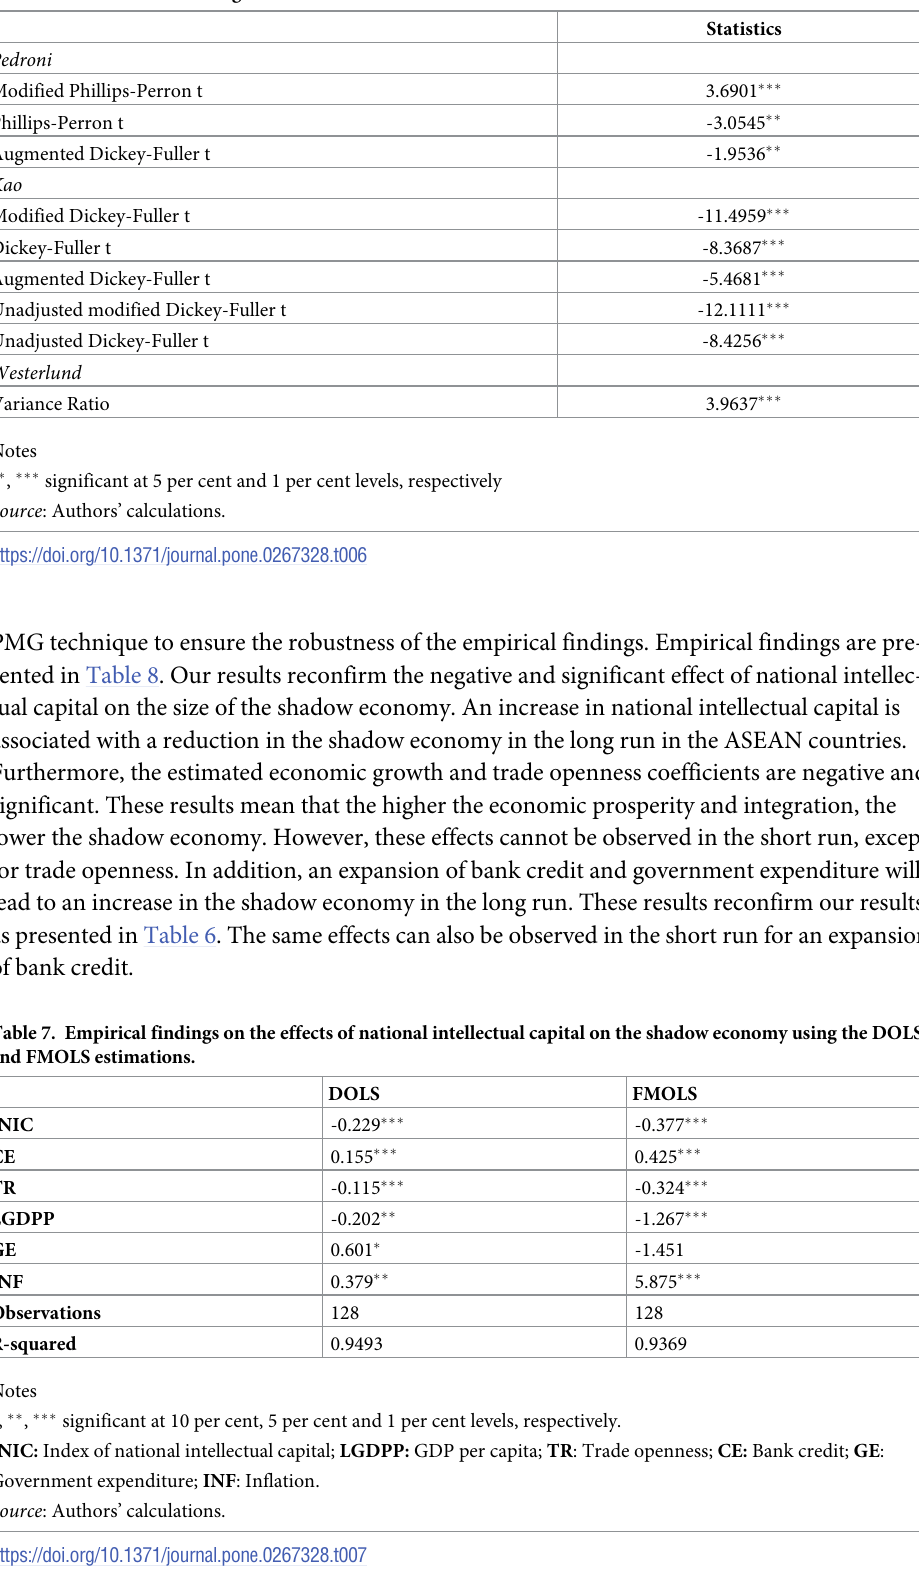
Table 6. Results of the cointegration test.